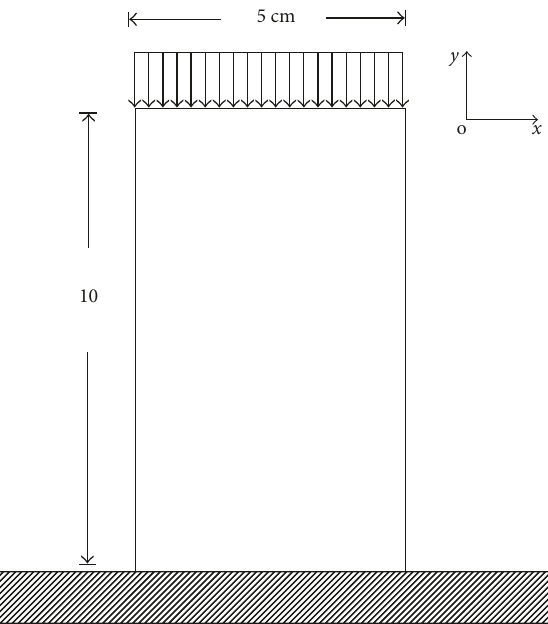
Figure 9: Geometry and boundary condition of the numerical